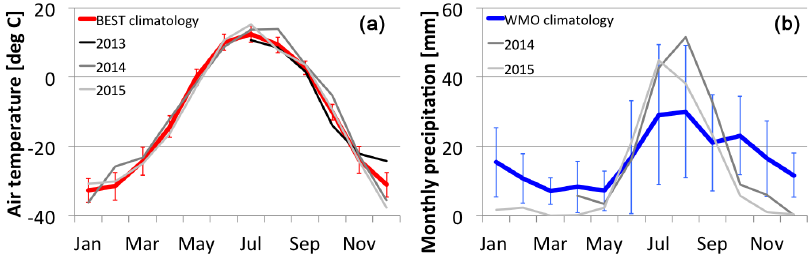
Figure 2. (a) Average annual course (1960–2009) and recent observations of monthly mean air temperature; (b) long-term average (1950– 1999) and recent observations of monthly precipitation sums for the Chersky